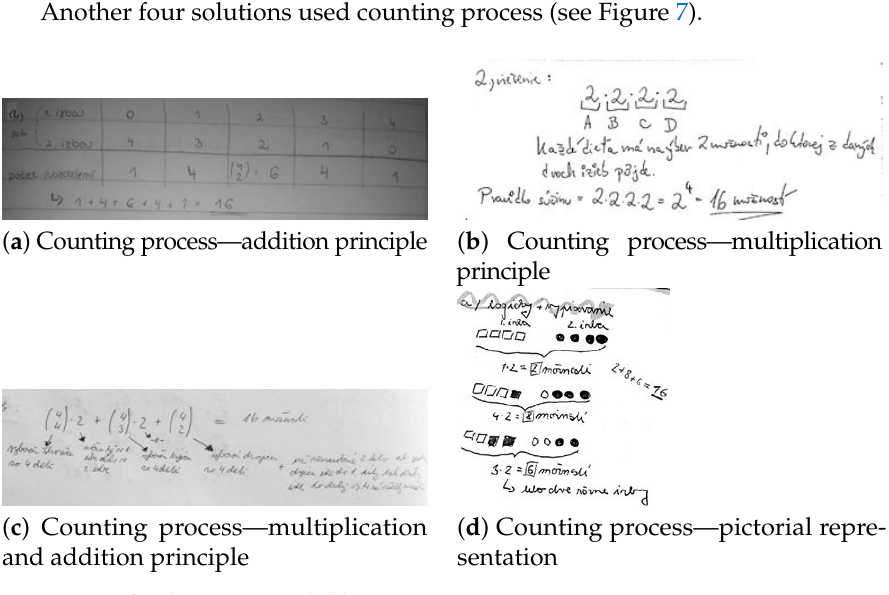
Figure 7. CSS for the MSTs 2.2 Children—Counting process. The last two examples of solutions from CSS apply formula (see Figure